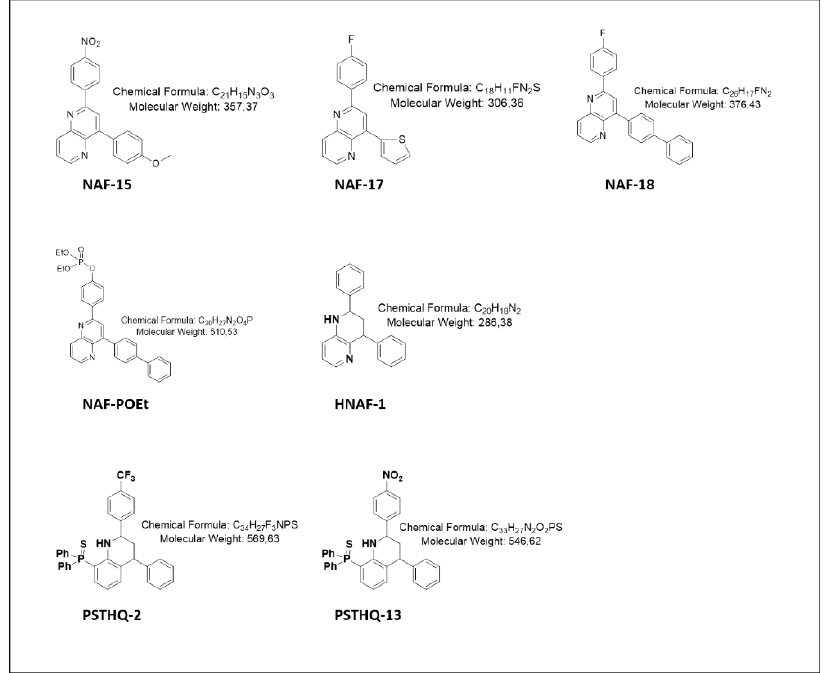
Figure 1. Molecular structure, chemical formula and molecular weight for the seven small compounds designed to inhibit the enzymatic activity of TDP1.